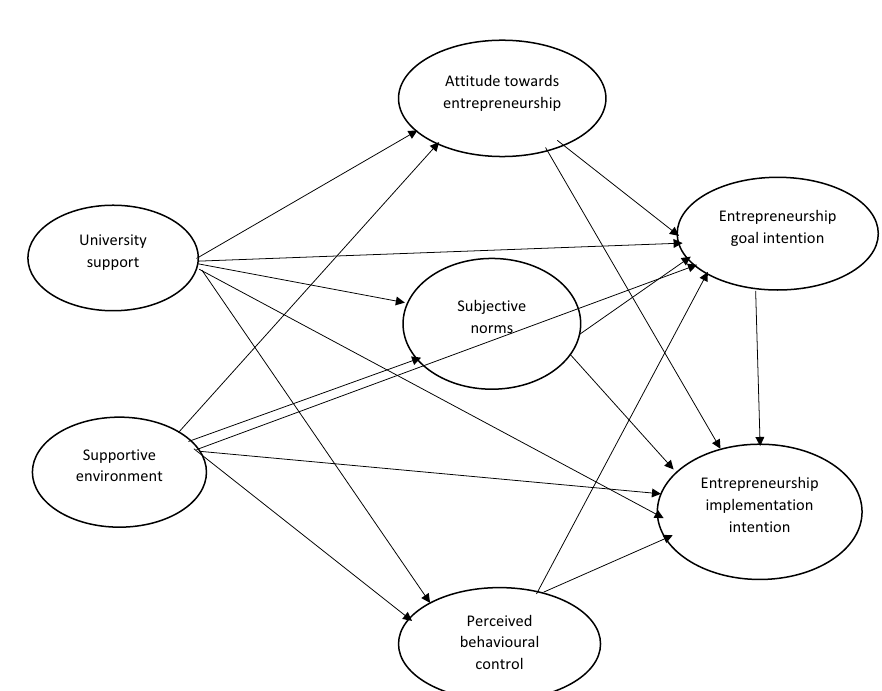
Fig. 1 HYPERLINK "sps:id::fig1||locator::gr1||mediaobject::0" Conceptual